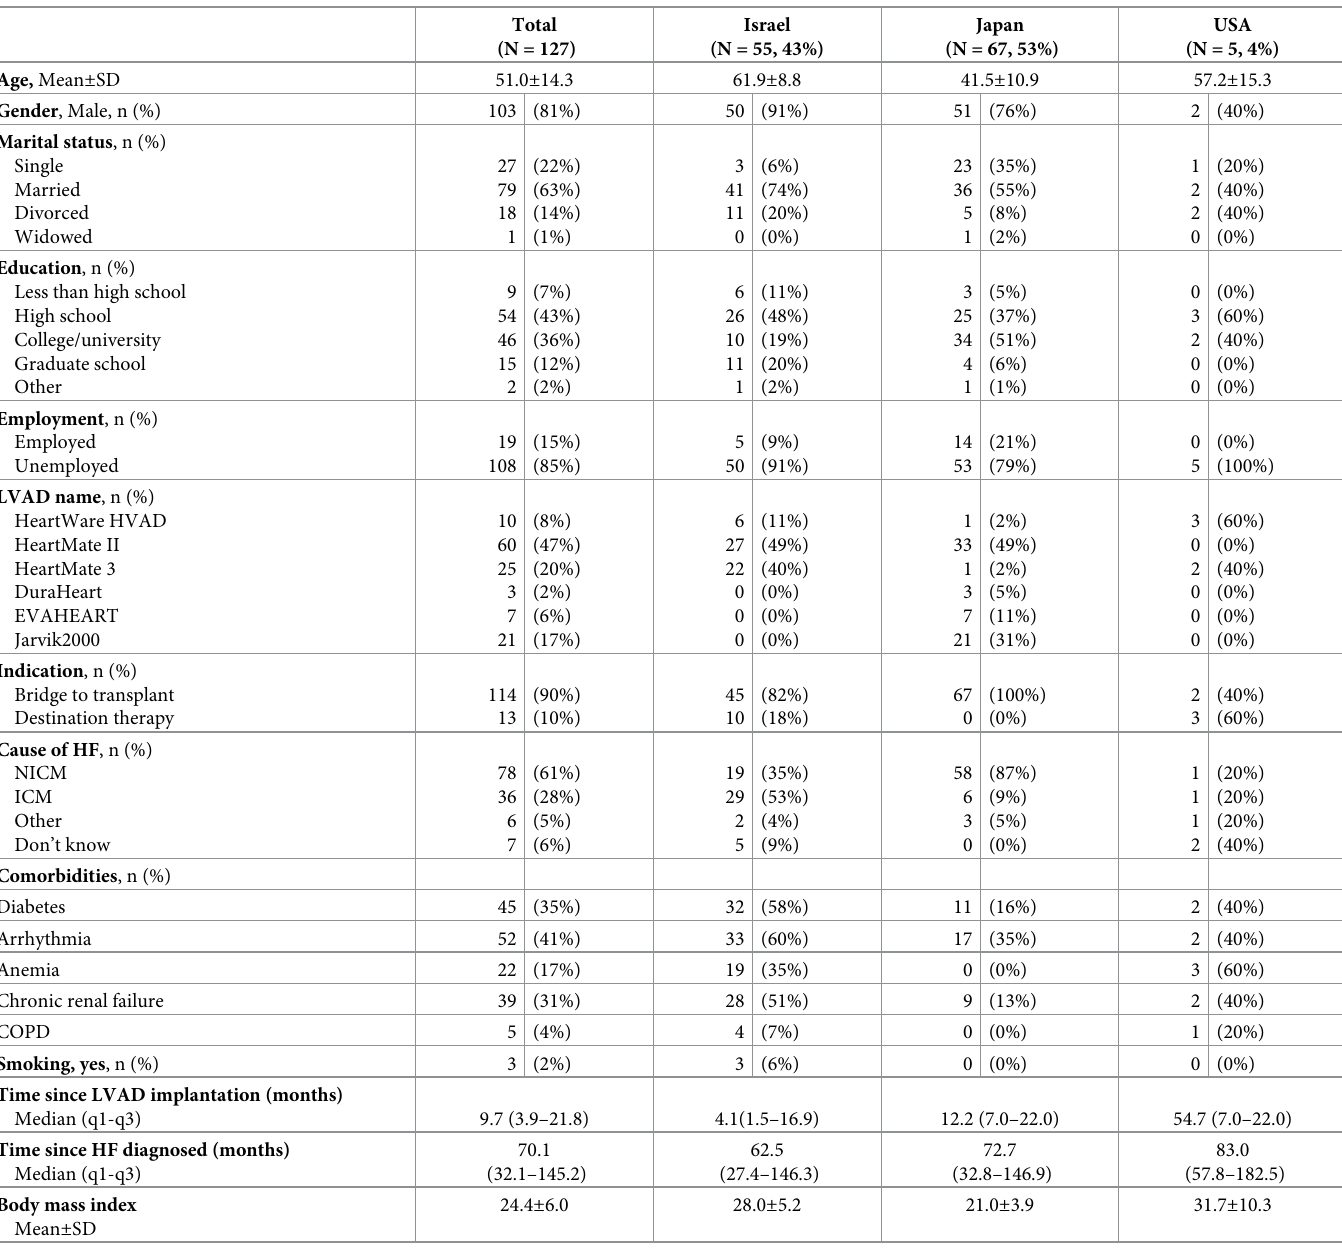
Table 1. Sociodemographic and clinical